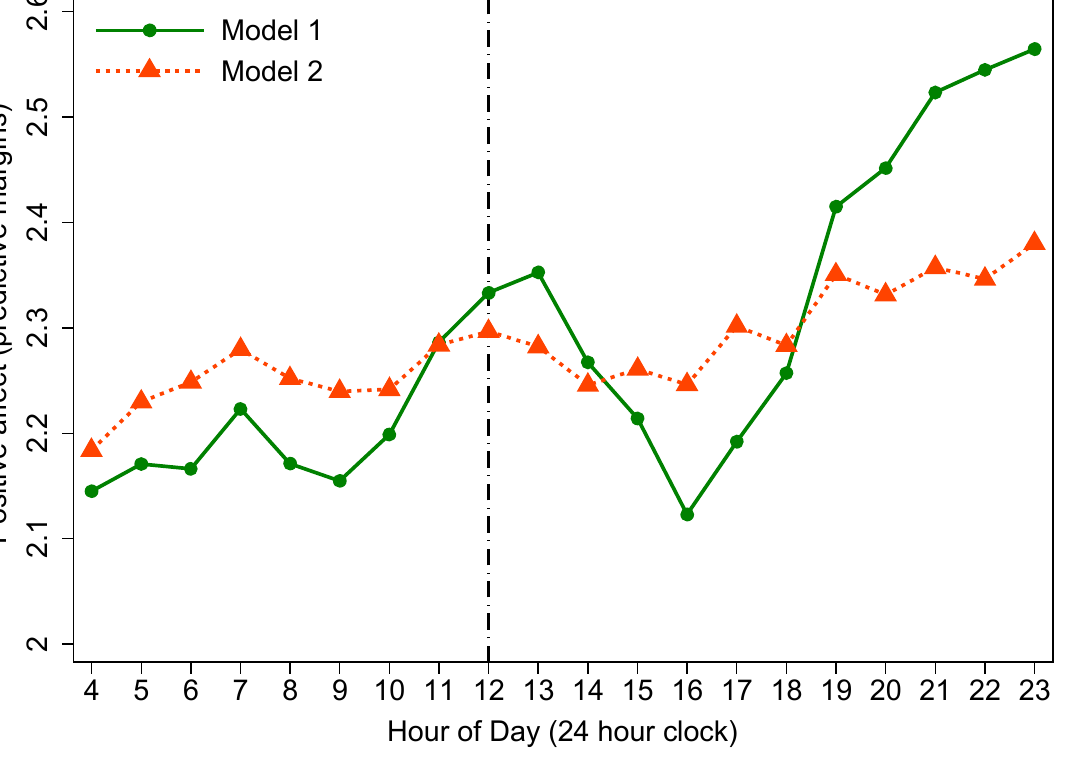
Figure 2. Diurnal rhythm of positive affect (reference group: 4:00).